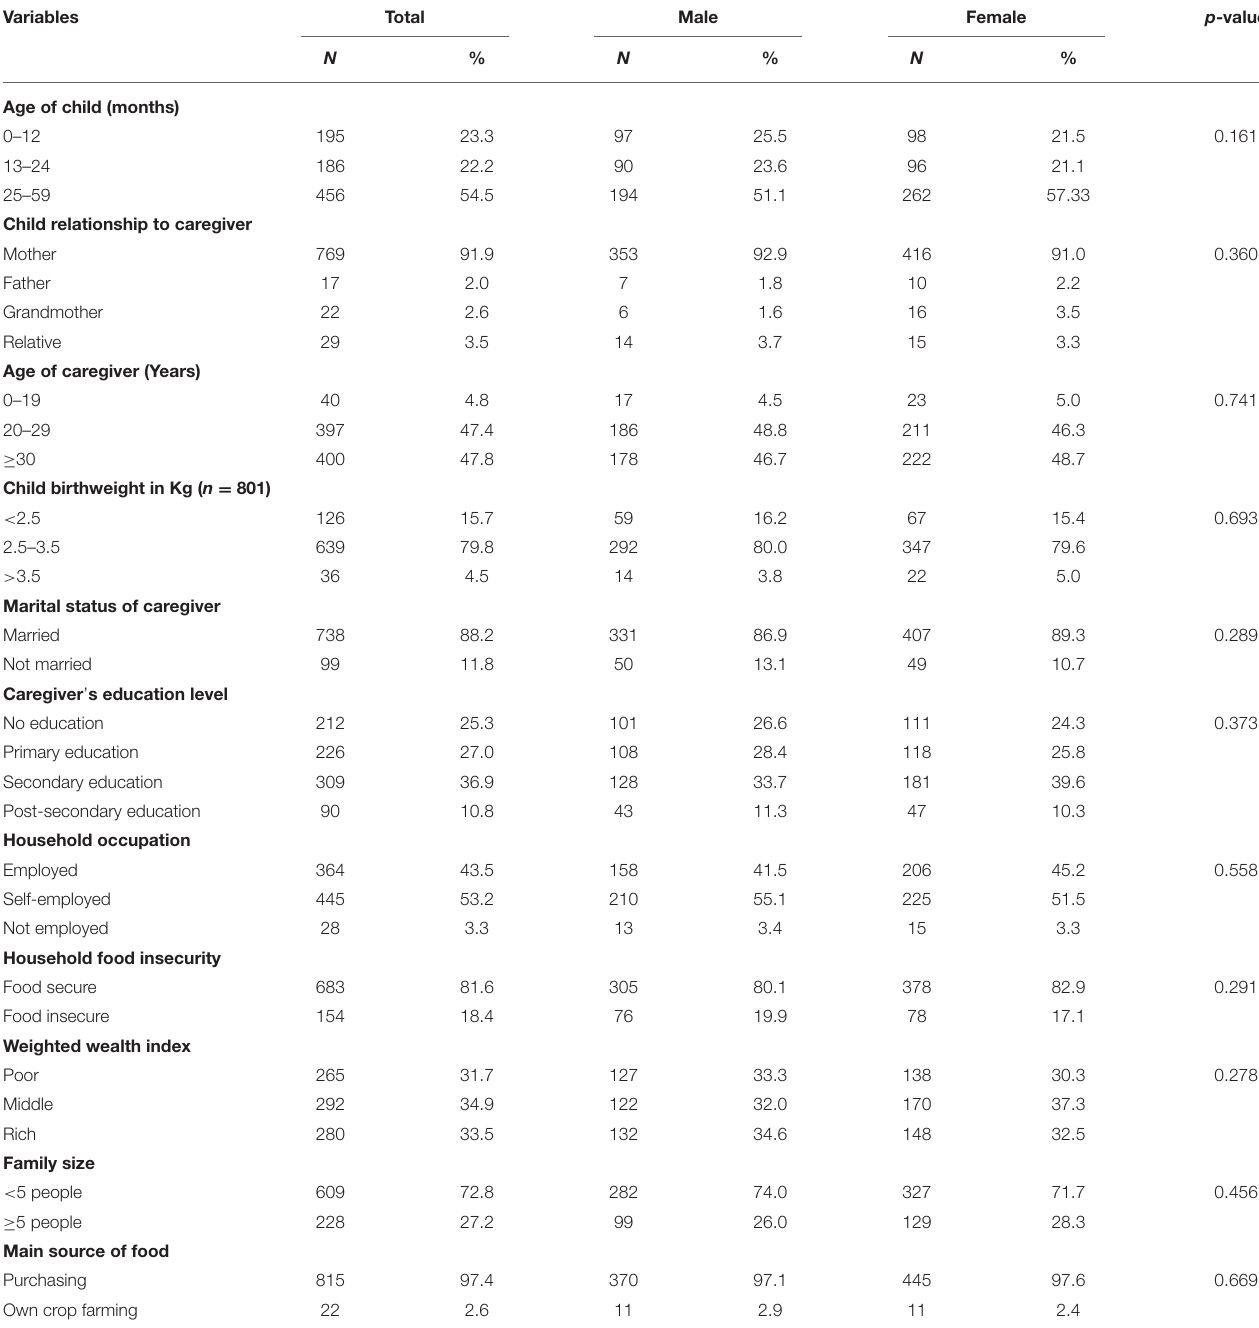
TABLE 1 | Socio-demographic and household characteristics of children aged 0–59 months in Bambao region, July 2021 ( N = 837). Variables Total